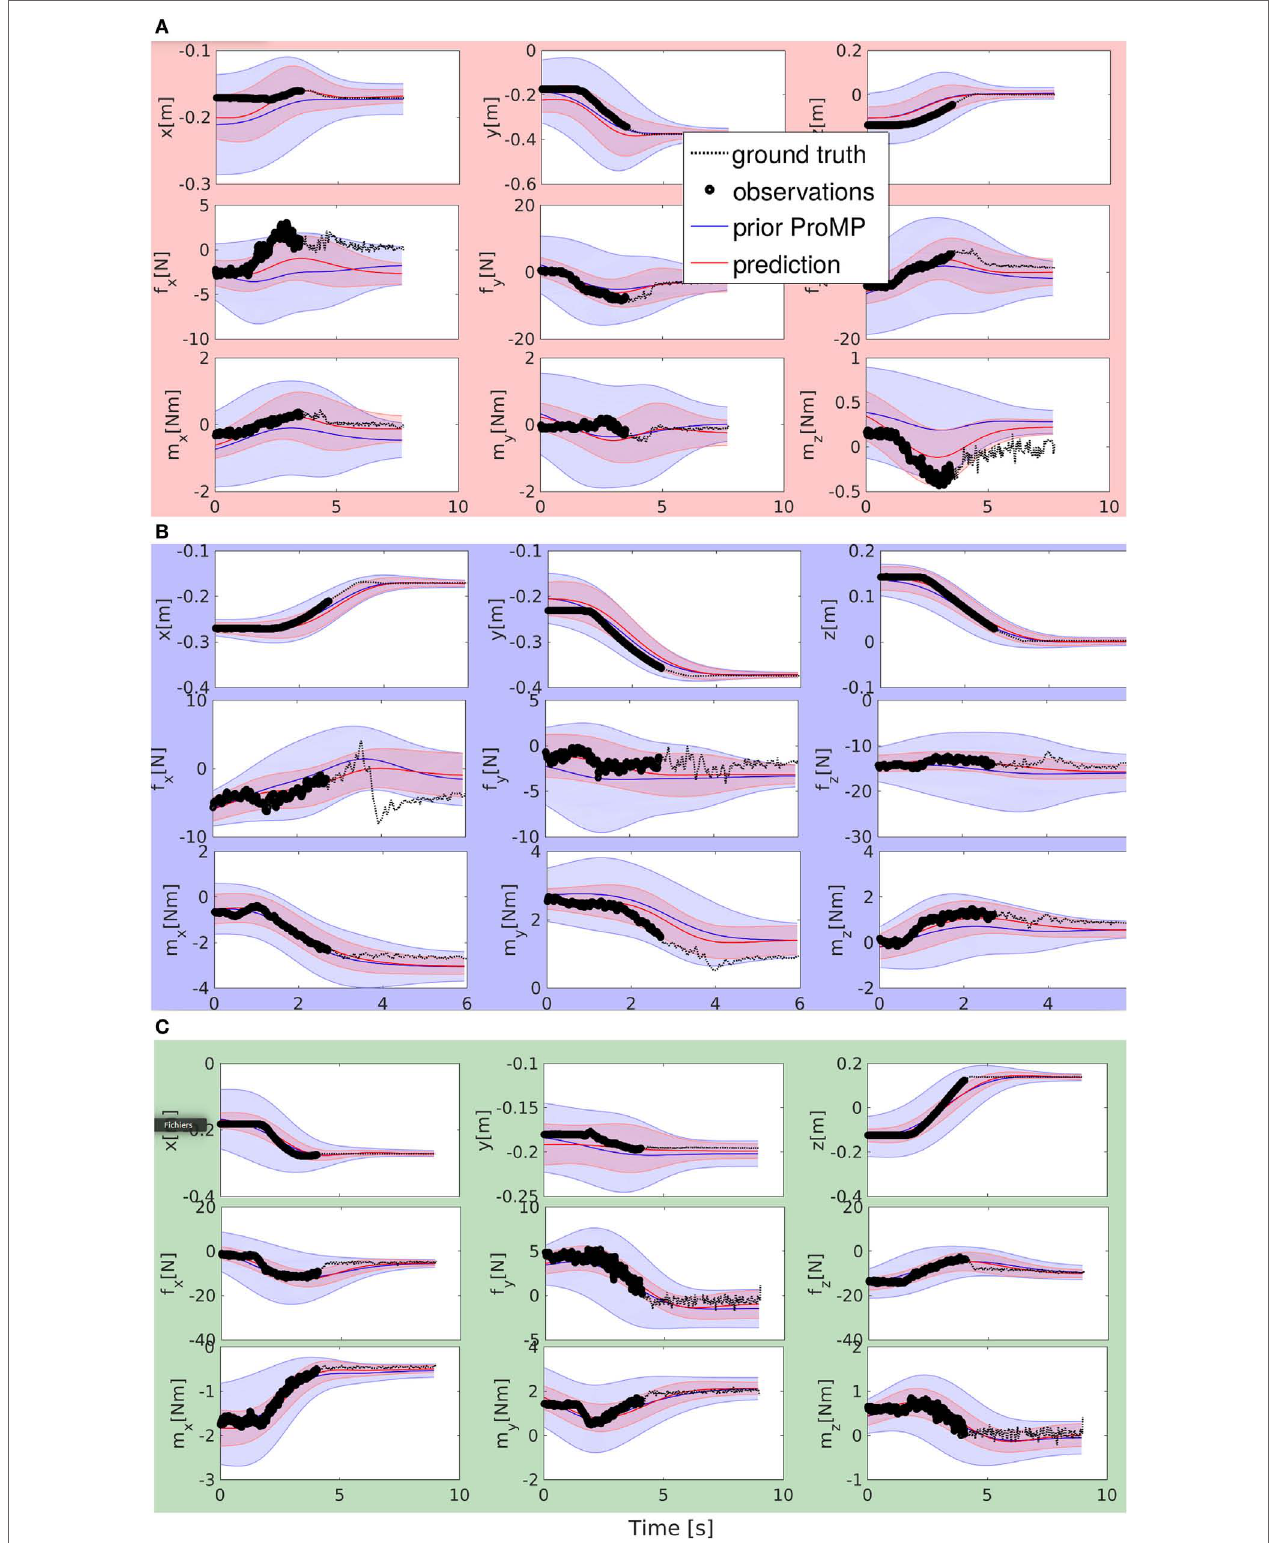
FIGURE 13 | The prediction of the future trajectory from the learned ProMPs computed from the position and wrench information for the 3-targets dataset on the real iCub ( Figure 11 ) after 40% of observations.